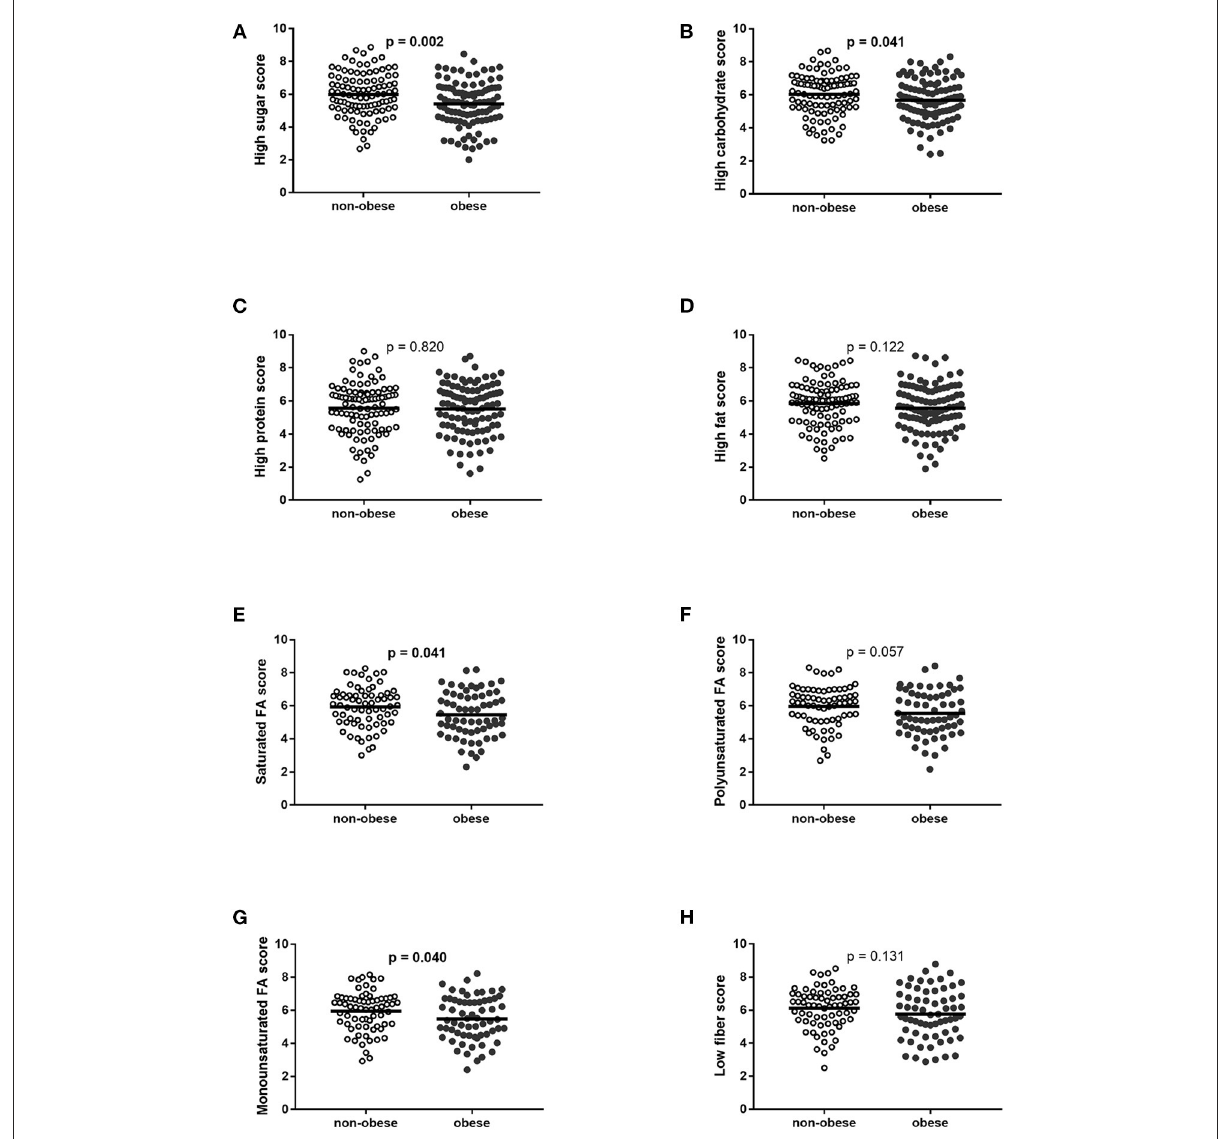
FIGURE1 Food preferences in non-obese and obese children and adolescents. (A) High sugar score, (B) high carbohydrate score, (C) high protein score, (D) high-fat score, (E) high saturated fatty acid score, (F) high polyunsaturated fatty acid score, (G) high monounsaturated fatty acid score, and (H) low fiber score. Displayed as mean and confidential intervals for the mean. Differences were calculated using the t- test. FA, fatty acids.